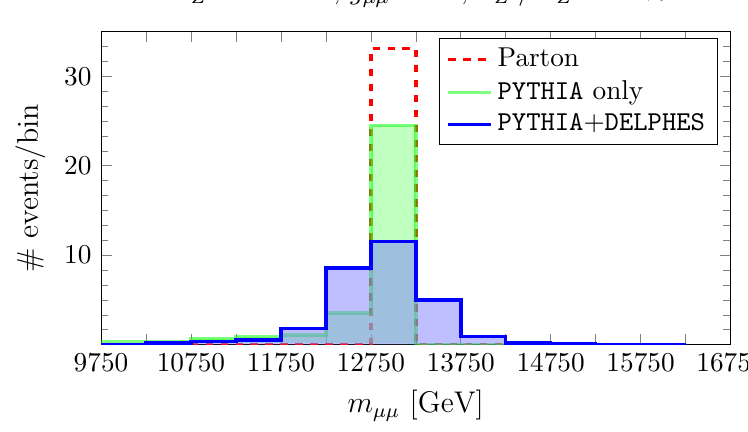
Figure 7 . The bleeding of a single parton level bin centred on m (cid:22)(cid:22) = 13 TeV for the Z 0 signal at the FCC. At parton-level, we expect 33.1 events (in 10 ab (cid:0) 1 ), after parton showering e(cid:11)ects are simulated by PYTHIA this reduces to 31.3 and after simulating detector e(cid:11)ects with DELPHES 3 ,